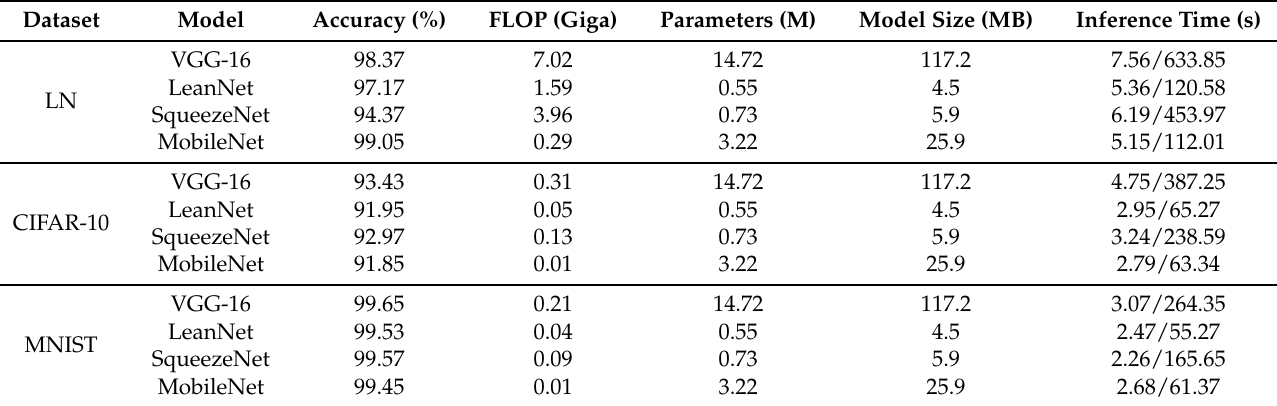
Figure 7. Curves of training loss and test accuracy for different networks. Compression ratio . As shown in Table 1, the number of parameters contained in different networks and the size of model generated under the Pytorch framework are recorded. When 80% channels are pruned, the parameter saving for LeanNet is more than 20 × , LeanNet also has an advantage in model size over the other two lightweight networks. Table 1. Overall result. The best test accuracy for different networks on three datasets is reported. The last column shows sample set contains 10,000 images